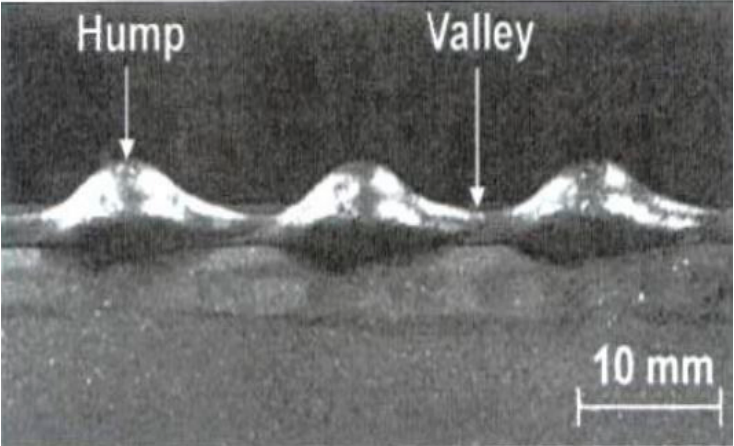
Figure 1. Humping phenomenon (after Nguyen et al. [14]).